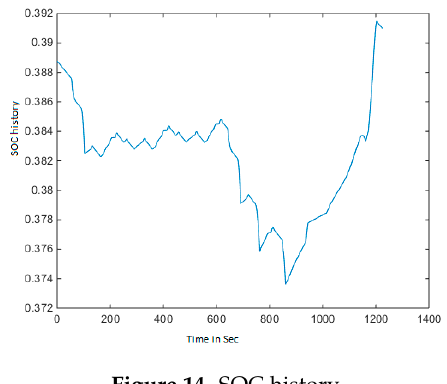
Figure 14. SOC history. Table 5. Optimization results for ECE-EUDC